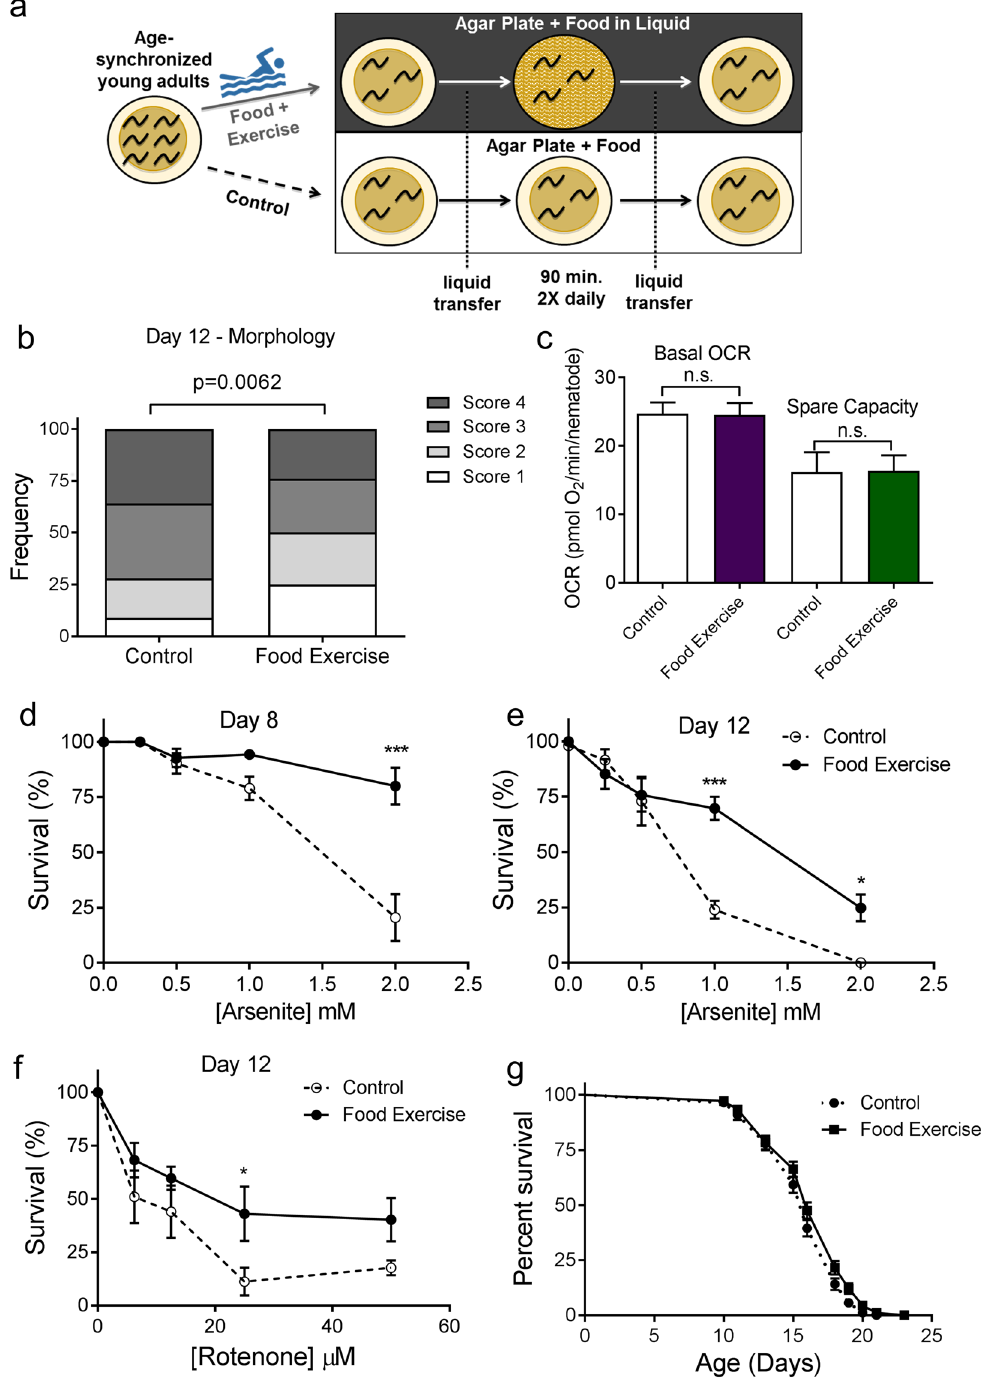
Figure 7. Exercise conditioning in food-containing medium protects muscle mitochondria and ameliorates toxicity of mitotoxicants, but fails to increase respiration or extend lifespan. In Panel a, a stylized depiction of the experimental design is shown; the design is described in detail in Methods. Briefly, animals were subjected to a similar 6-day exercise regimen in media containing OP 50 bacteria. Cartoon depiction of swimming man obtained under Creative Commons CC0 from pixabay.com. Panel b shows score distributions for mitochondrial morphology on day 12, as described for Fig. 2. Data shown are from n = 70 animals from each group from two independent biological replicates. Statistical significance is based on Chi-squared analysis of the distributions. Panel c represents the respiration in control animals and those exercised in food-containing media, as described for Fig. 4. Data shown are from 10 technical replicates and two independent biological replicates. Panels d and e represent 24-hour survival in varying concentrations of arsenite for day 8 and day 12 animals, respectively. Panel f shows 24-hour survival of day 12 nematodes in rotenone. Survival for rotenone was not performed on day 8 due to high resistance of day 8 adults to rotenone (see Fig. 5). For lethality, data are from two